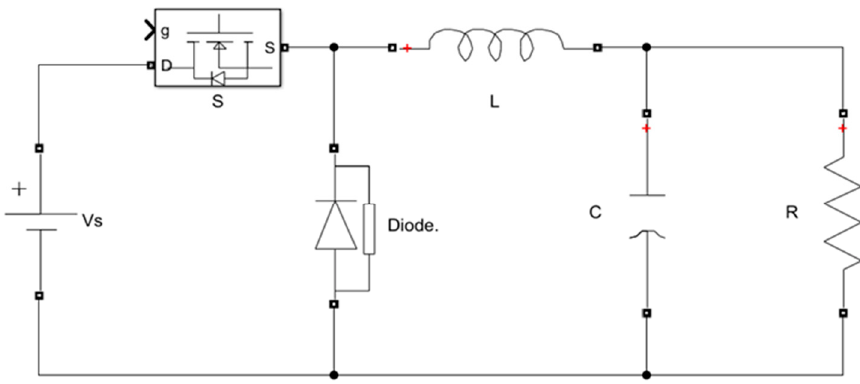
Figure 3. Buck converter circuit.